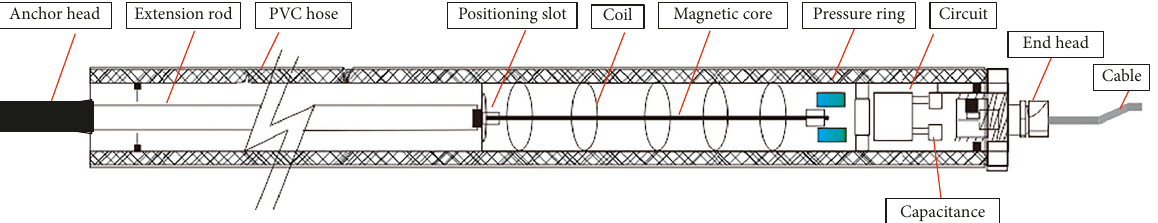
Figure 2: Structural cross section of the displacement meter.